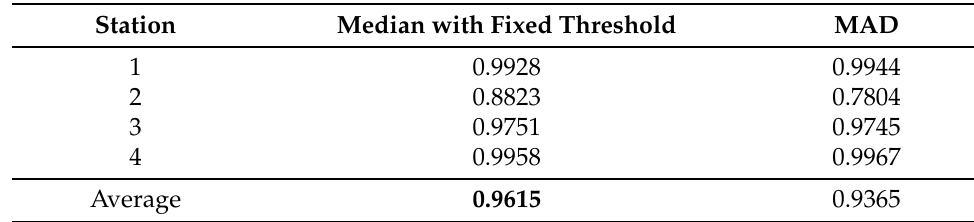
Table 3. F1-score resulting from anomaly detection methods.